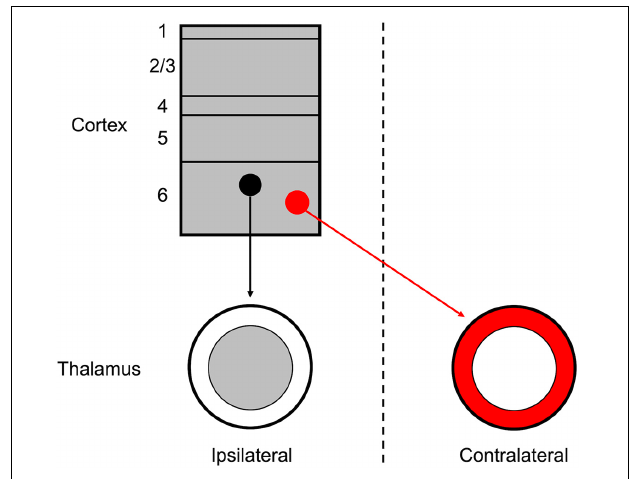
FIGURE 4 | Schematic organization of the layer 6 insular corticothalamic projections. The insular cortex is composed of both ipsilaterally projecting (black) and contralaterally projecting (red) corticothalamic (CT) neurons, which form separate, yet interdigitated, groups across layer 6. The ipsilateral CT projection terminates in a “core” region of the thalamus, the presumed VPMpc, while the contralateral CT projection terminates in a “shell” region surrounding the ipsilateral